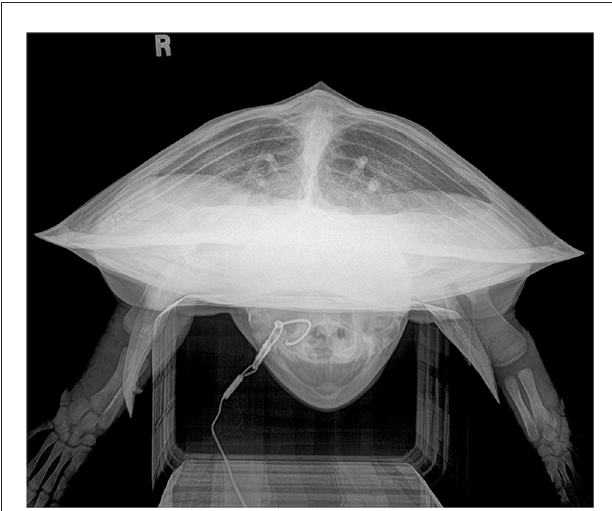
FIGURE3 Rostrocaudal (RoCd) projection of a hook-and-line capture, otherwise healthy juvenile Kemp’s ridley sea turtle ( Lepidochelys kempii ). The lung fields are asymmetric with the right lung field hypoinflated and reduced in volume slightly when compared to the left lung field due to non-uniform gas accumulation within the GI tract. The lung fields fill ∼ 40% of the coelomic cavity. Both the left and right main bronchus, pulmonary arteries (dorsal), and pulmonary veins (ventral) are evident. This radiograph represents a normal